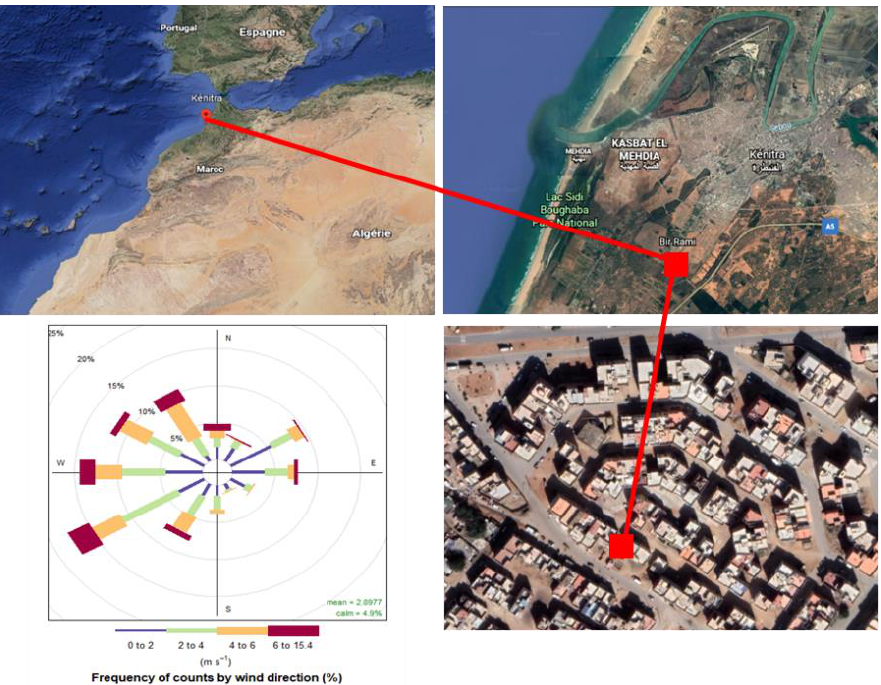
Figure 1. The sampling site (red square) is located in the Atlantic region (upper left panel), at a distance from the city center (upper right panel), and in an urban area (bottom right panel). The wind was based on hourly averages of wind speed and wind direction (bottom left panel). The filters from the dichotomous sampler were weighed before and after sampling, using a Sartorius microbalance (ME5, Göttingen, Germany) with 1 µ g sensitivity. After 24 h of equilibrium at room temperature with the requisite ambient relative humidity, filter weighing was achieved. The error for each weighing was generally in the order of 18 µ g, corresponding to an average uncertainty of 9% for PM 2.5 and 6% for PM 2.5–10 measurements. Loaded filters were handled equally before being weighed for the gravi- metric determination of PM mass. The PM 10 mass concentrations were calculated by the arithmetic sum of the PM 2.5–10 and the corresponding PM 2.5 mass concentrations. A multi-wavelength absorption black carbon instrument (MABI) measures light ab- sorption in a filter at seven different wavelengths: 405 nm, 465 nm, 525 nm, 639 nm, 870 nm, 940 nm, and 1050 nm [22] and is also used to differentiate between light-absorbing car- bon from high-temperature fossil fuel combustion (such as diesel vehicle engines) and biomass burning. MABI provides a powerful tool for identifying source contributions and determining the light-absorbing carbon content of filters using quantitative analysis